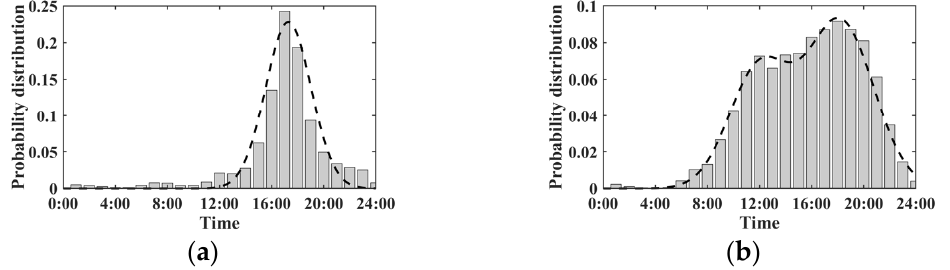
Figure 2. Distribution of end times of trip on weekdays. ( a ) Distribution of end times of works trips, ( b ) Distribution of end times of social shopping trips.